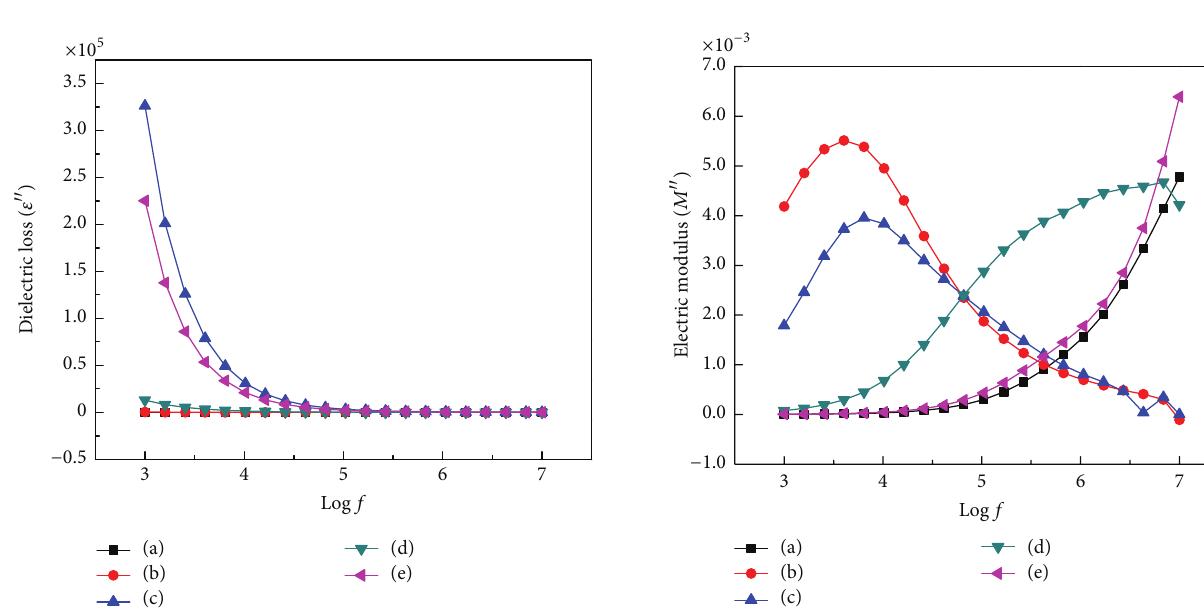
Figure 7: Variation of dielectric loss with frequency for (a) 1wt% Ppy/TiO 2 , (b) 2wt% Ppy/TiO 2 , (c) 3 wt% Ppy/TiO 2 , (d) 4wt% Ppy/TiO 2 , and (e) 5wt% Ppy/TiO 2 composites.